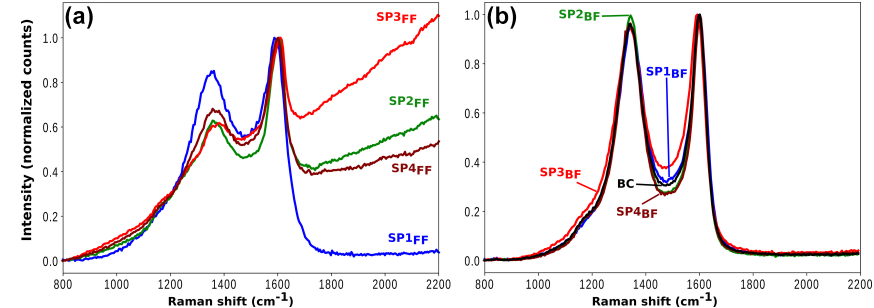
Figure 10. Raman spectra of SP1 (blue), SP2 (green), SP3 (red), and SP4 (brown) samples on front filter (a) and back filter (b) . For all samples, plots are normalized to the maximum intensity of the G band. The spectrum of pure black carbon (BC) deposited on a QFF is plotted in black in panel (b) for comparison.